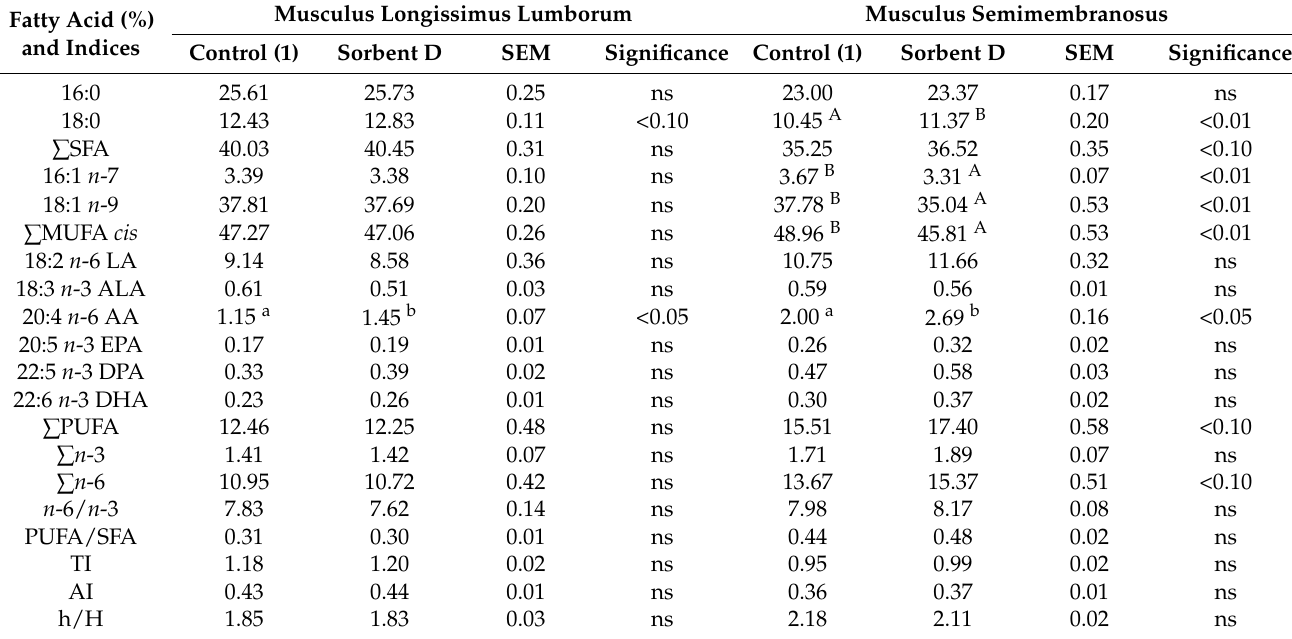
C18:1 n -9 acids (by 2.74 p.p.) and Σ MUFA cis (by 3.15 p.p.) was found, in comparison with the control group. Similar to MLL, a significantly higher proportion of arachidonic acid was also found (by 0.69 p.p., p < 0.05) in fatteners fed with biochar. Table 1. Composition of fatty acid (% of total fatty acids) of Musculus longissimus lumborum and Musculus semimembranosus.